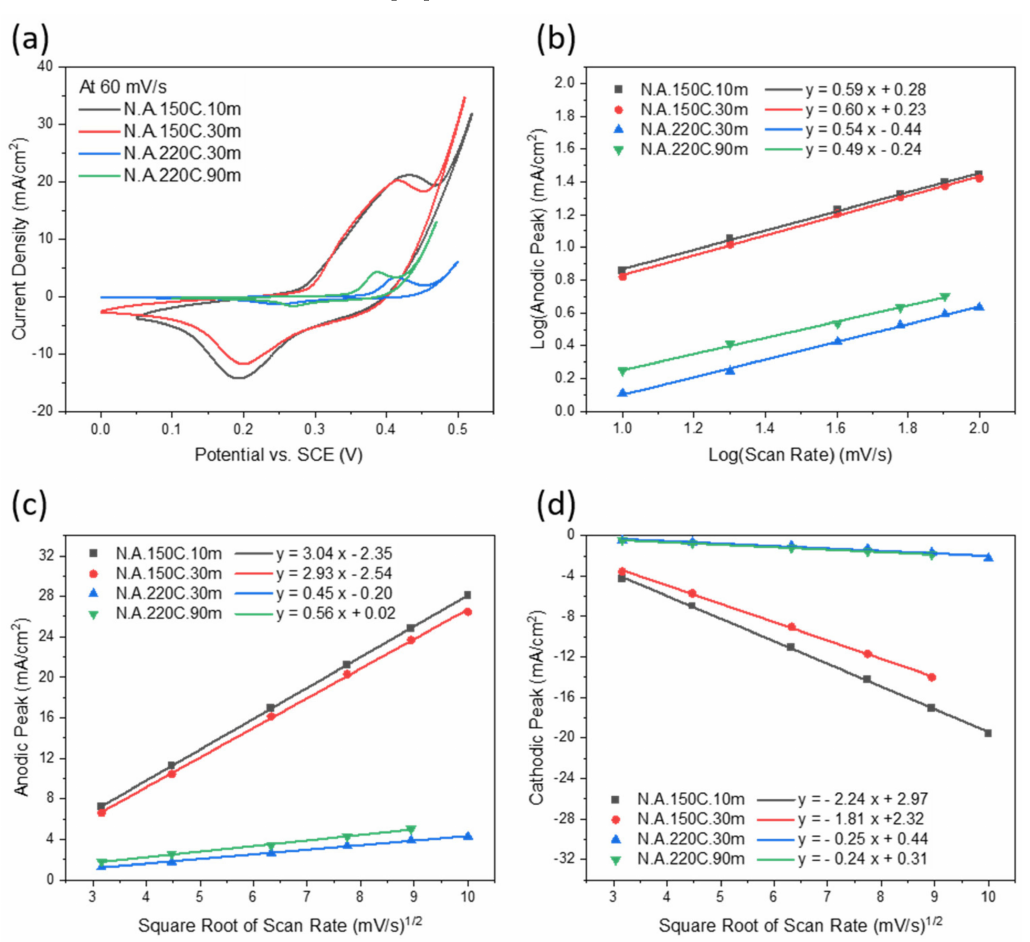
Figure 5. ( a ) CV curves of all electrodes at a scan rate of 60 mV/s; ( b ) the logarithmic anodic peaks vs. the logarithmic scan rates; ( c , d ) anodic and cathodic peaks vs. the square root of scan rates,